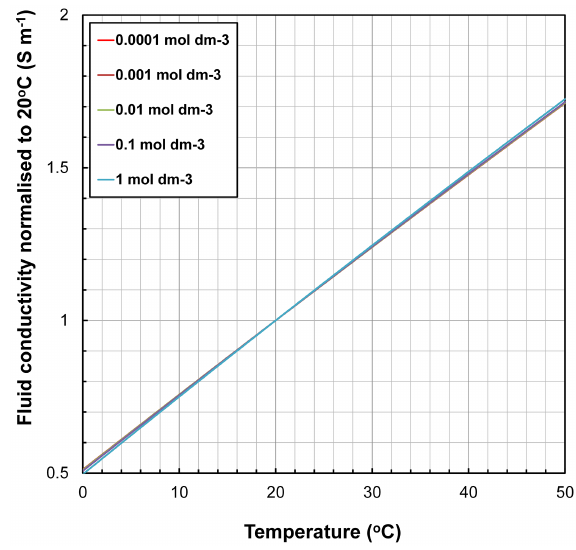
Figure 7. Resistivity of an aqueous solution of NaCl as a function of temperature for a number of different pore fluid salinities using the method of Sen and Goode (1992a, b). Dashed lines show the change in conductivity resulting from a difference in temperature between 20 and 25 ◦ C. Note that the normalised curves from the whole range of salinities including in the figure are almost